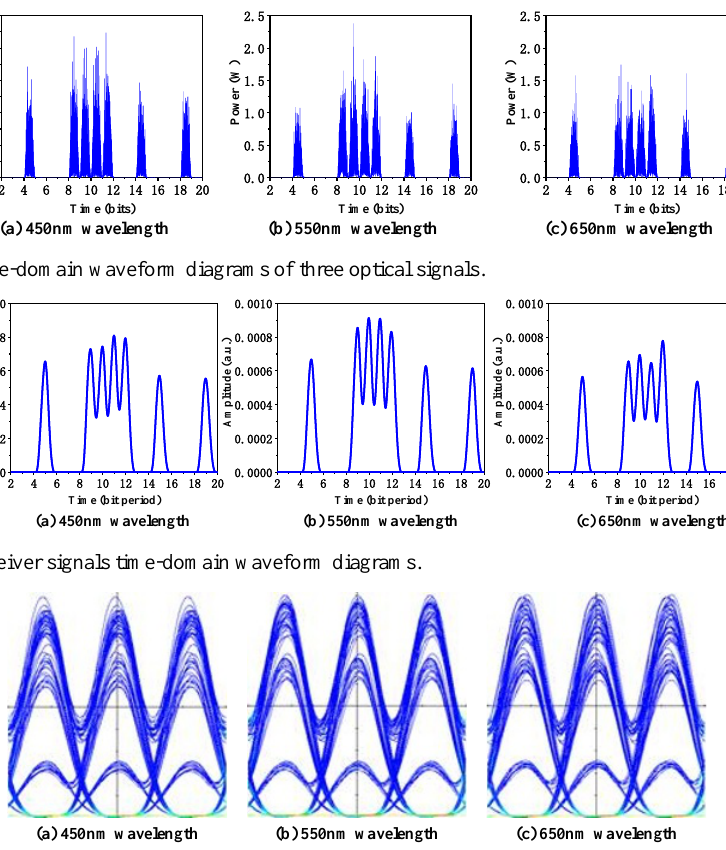
Fig.4. Eye diagrams measured at different working wavelengths .